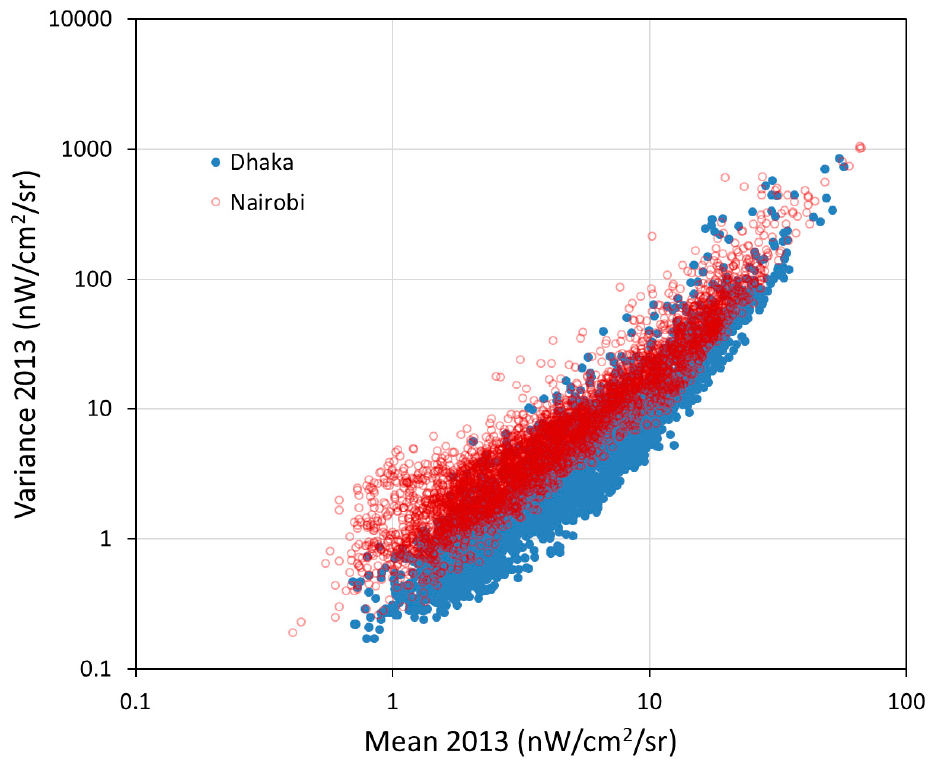
Figure 40. Variance versus mean for grid cells in Nairobi and Dhaka. While the range of means is quite similar between the two cities, Nairobi has a higher variance. This is an indication that the voltage varies over time in Nairobi as compared to Dhaka.